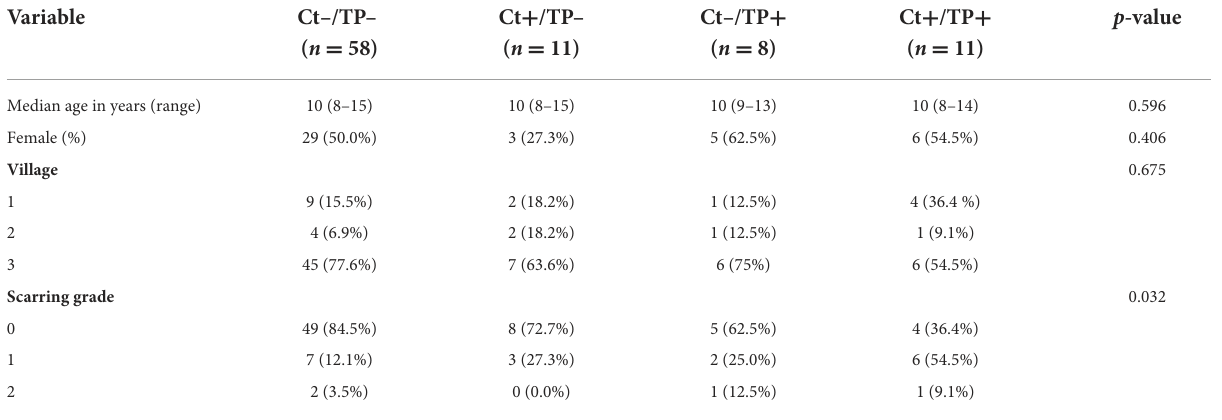
TABLE 2 Clinical information and demographics of the four study groups pre-MDA.